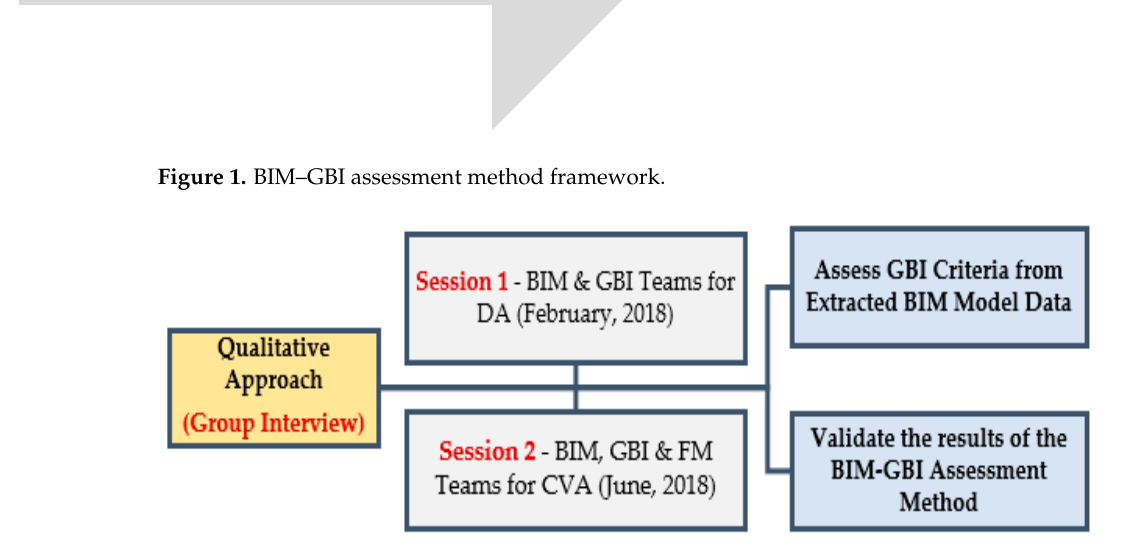
Figure 1. BIM–GBI assessment method framework.